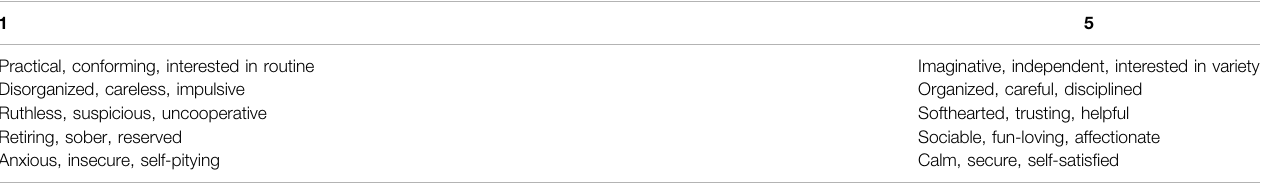
TABLE 9 | Big fi ve opposing characteristics presented as anchors to the Likert scale.